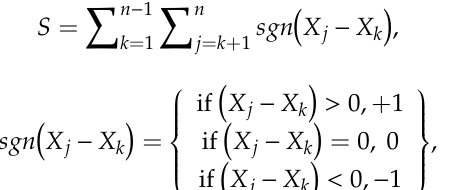
Figure 4. The mean annual precipitation anomalies over land areas for the globe and one latitudinal band from the five global precipitation datasets CRU, GHCN, GPCC, Smith et al. and GPCP compared to the period of 1981–2000 (Source: IPCC report, 2013 [60]).